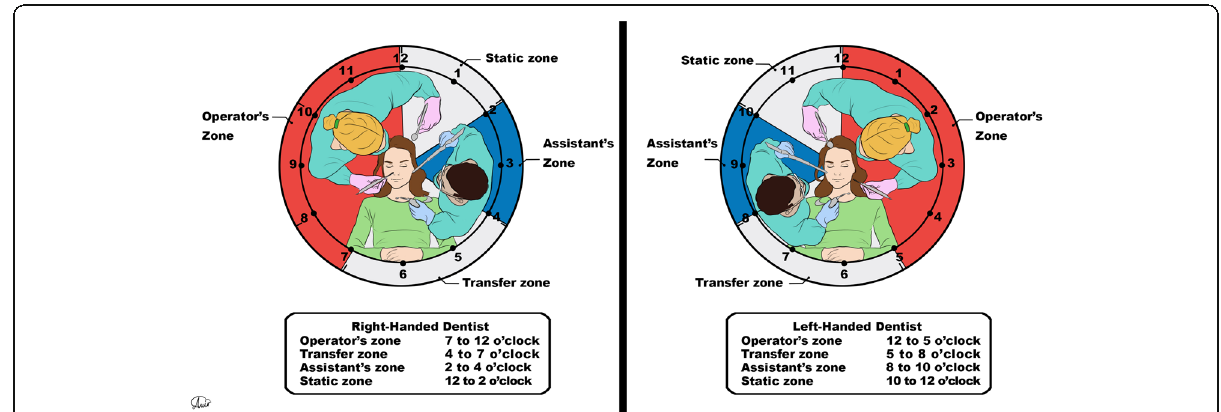
Fig. 1 Four-handed dentistry. Zones of activity for right-handed and left-handed